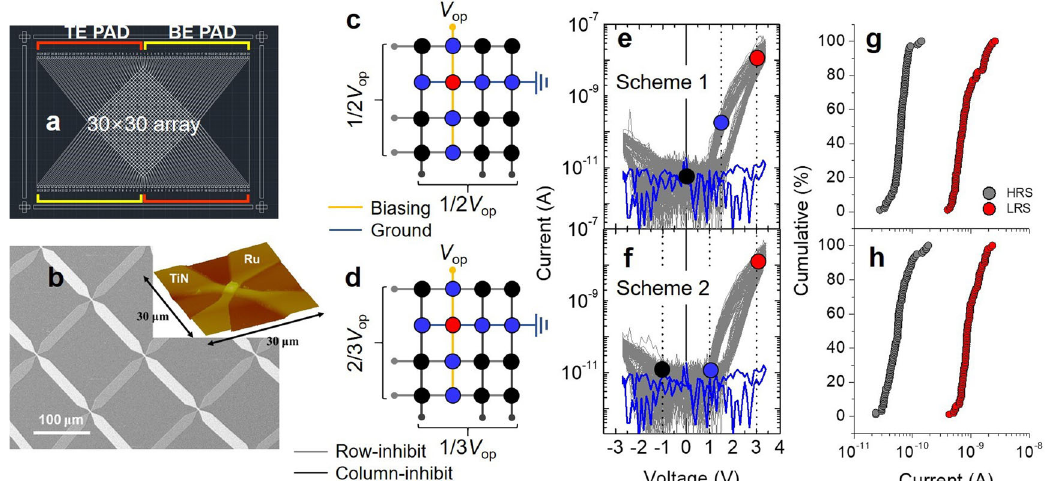
Fig. 6 30 × 30 CA of SRMCs. a Top view of CA layout. b Scanning electron microscope image of the array. The inset shows an atomic force microscope image of a unit SRMC. Schematic of c Scheme 1 and d Scheme 2. Appended I – V loops of 100 randomly chosen SRMCs (three loops for each SRMC), which were measured using e Scheme 1 and f Scheme 2. For V op = 3 V, voltage across selected cell (red- fi lled circle), unselected group 1 cell (blue- fi lled circle), and unselected group 2 cell (black- fi lled circle) is indicated. Open circuit current was also plotted (blue line). The currents read using Scheme 1 and Scheme 2 on the 100 SRMCs are shown in the distributions in g and h , respectively. Scheme 1: the mean current m and standard deviation σ for HRS and LRS are (6.5 × 10 − 11 A, 1.8 × 10 − 11 ) and (9.3 × 10 − 10 A, 5.1 × 10 − 10 ), respectively. Scheme 2: (6.2 × 10 − 11 A, 3.2 × 10 − 11 ) and (1.0 × 10 − 9 A, 4.1 × 10 − 10 ) for HRS and LRS, respectively. Table 2 Voltage across cells over a CA for Schemes 1 – 4.